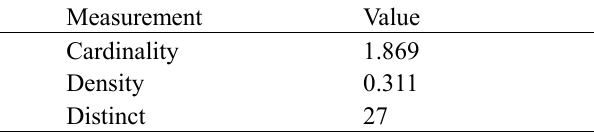
Table 1. Statistic indexes of the music emotion dataset